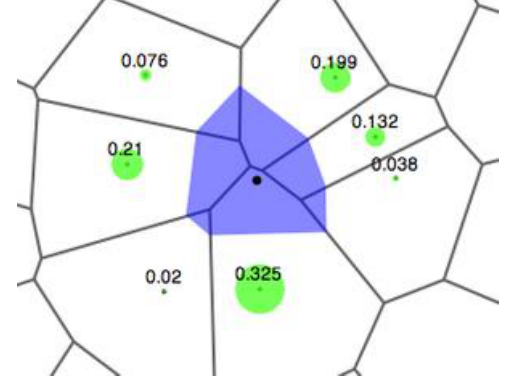
Figure 6: Natural Neighbour Inverse Distance Weighted Interpolation